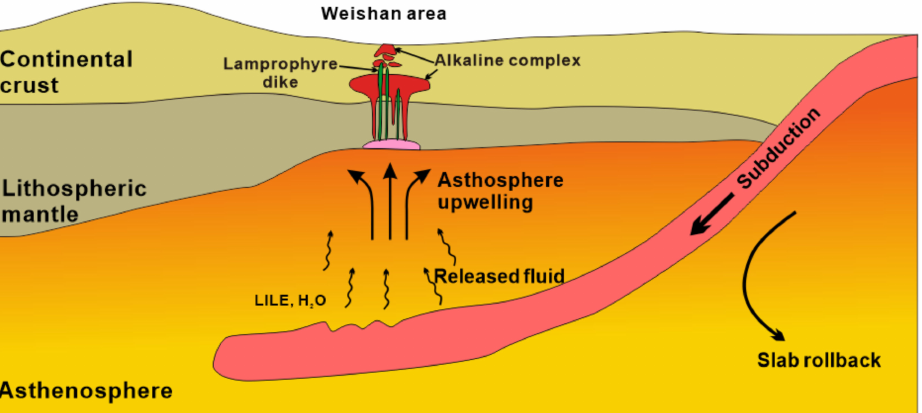
Figure 14. Tectonic schematism showing the formation of the lamprophyres in the Weishan area of Luxi Terrane